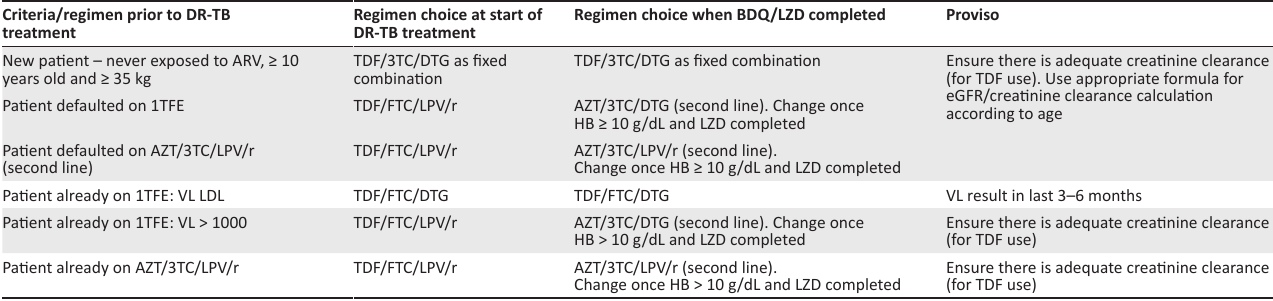
TABLE 2: Antiretroviral regimens for patients on drug-resistant tuberculosis treatment. Criteria/regimen prior to DR-TB treatment